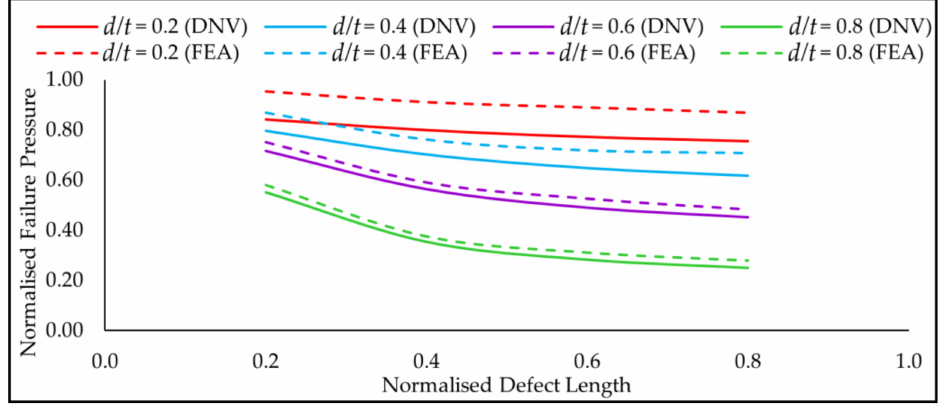
Figure 10. Normalized failure pressure predictions of FEA and DNV for API 5L X80 pipe subjected to internal pressure